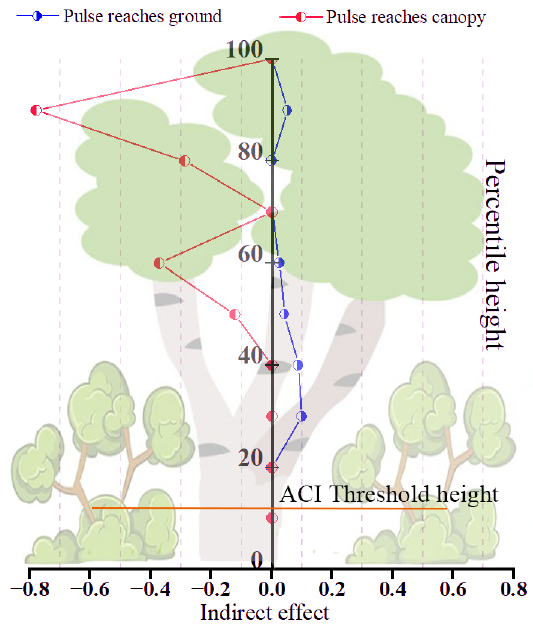
Figure 13. Indirect effect along the vertical gradient.